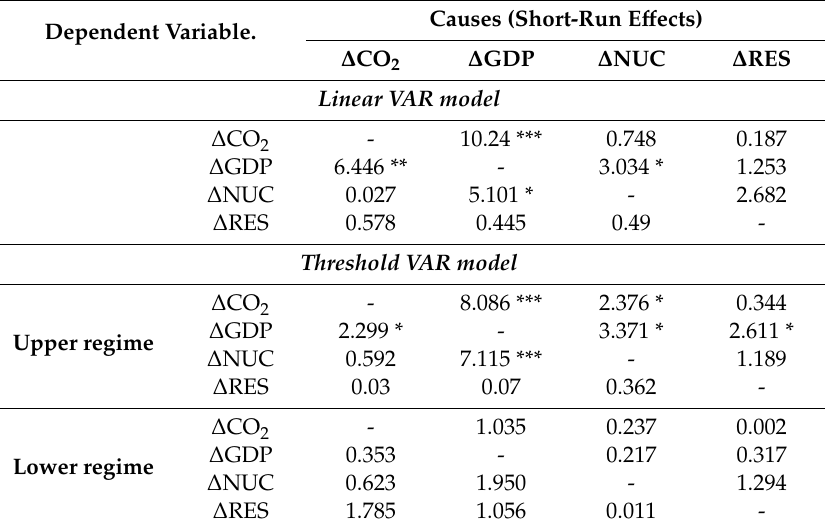
Table 4. Test for Granger causality in